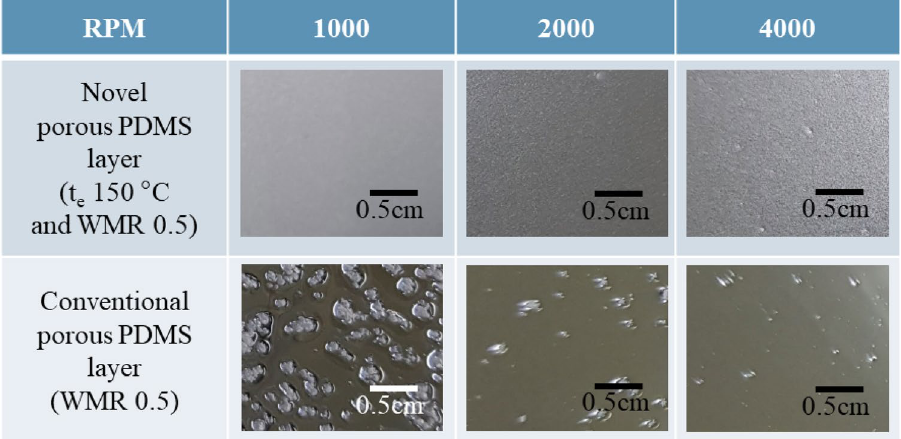
Figure 6. Surface of the present porous PDMS layer and the non-crystallized PDMS layer, respectively fabricated at the spin-coating RPM of 1000, 2000, and 4000.